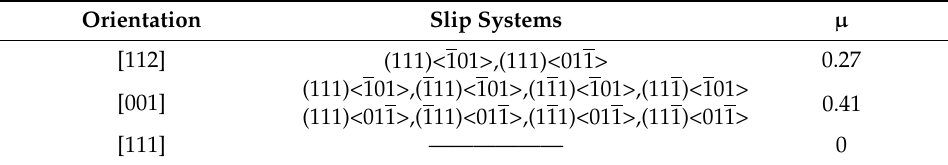
¯ µ in the plates with different